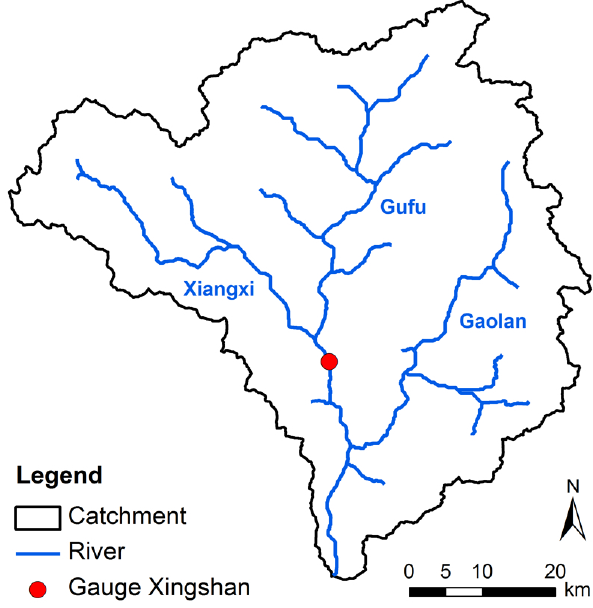
Fig. 1. The Xiangxi Catchment with the location of Gauge Xing-